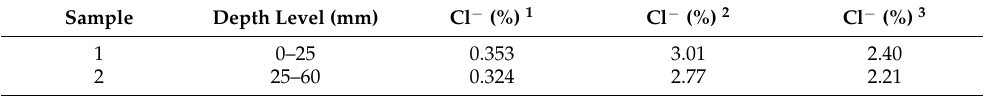
Table 2. Chloride content of samples 1 and 2, taken at the rebar electrical connection point.